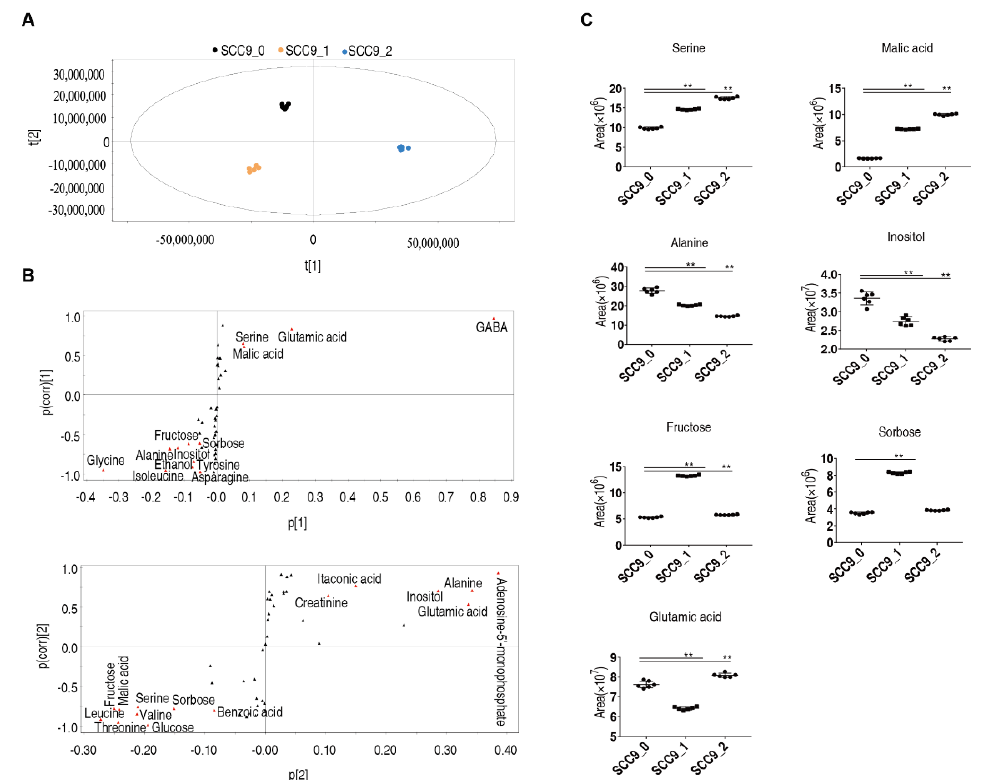
Figure 4. Screening of marker metabolites in SCC-9 cells stimulated by cisplatin. OPLS-DA analysis ( A ). S-plot analysis ( B ). Relative abundance of marker metabolites ( C ). SCC9_0, SCC9_1 and SCC9_2 represent the SCC-9 cells treated with cisplatin for 0 h, 24 h or 48 h. **, p < 0.01. OPLS-DA analysis of differential metabolites showed that t [1] could distinguish untreated HOEC cells from 2 groups treated for 24 h or 48 h, and t [2] could distinguish cells treated for 24 h from the cells untreated or treated for 48 h (Figure 8A). Marker metabolites induced by cisplatin were determined through S-plot analysis, and 15 and 10 marker metabolites were identified by t [1] and t [2], respectively (Figure 8B). Inositol, ethanol, isoleucine, hexadecanoic acid, and creatinine were five common biomarkers screened by two factors (Figure